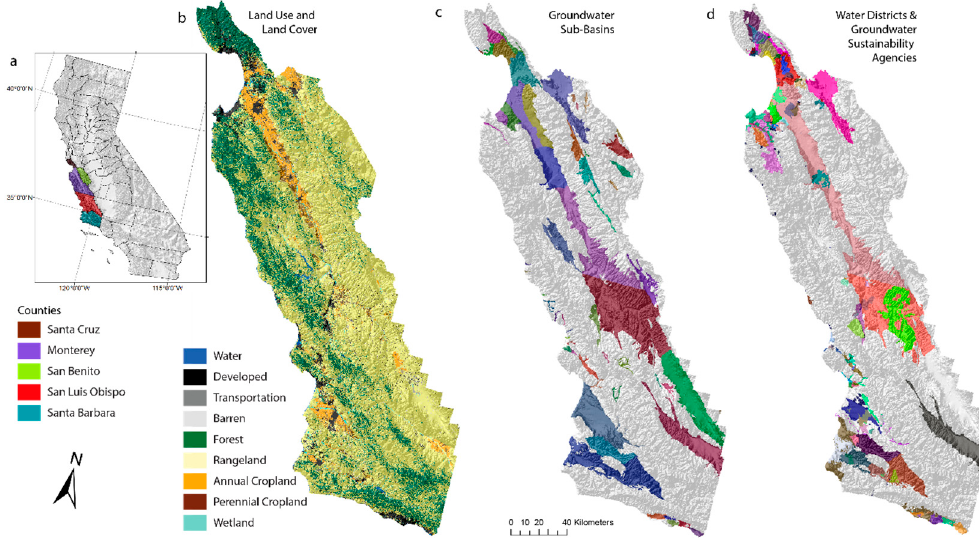
Figure 1. California’s Central Coast Study Area including ( a ) counties, ( b ) land use and land cover in 2001, ( c ) groundwater sub-basins, and ( d ) aggregated water district and groundwater sustainability agency jurisdictions. Complete lists of regions included in ( c ) and ( d ) located in the Supplementary Materials Tables S1 and S2, respectively. The base map is from the U.S. Geological Survey’s National Map Atlas [65].